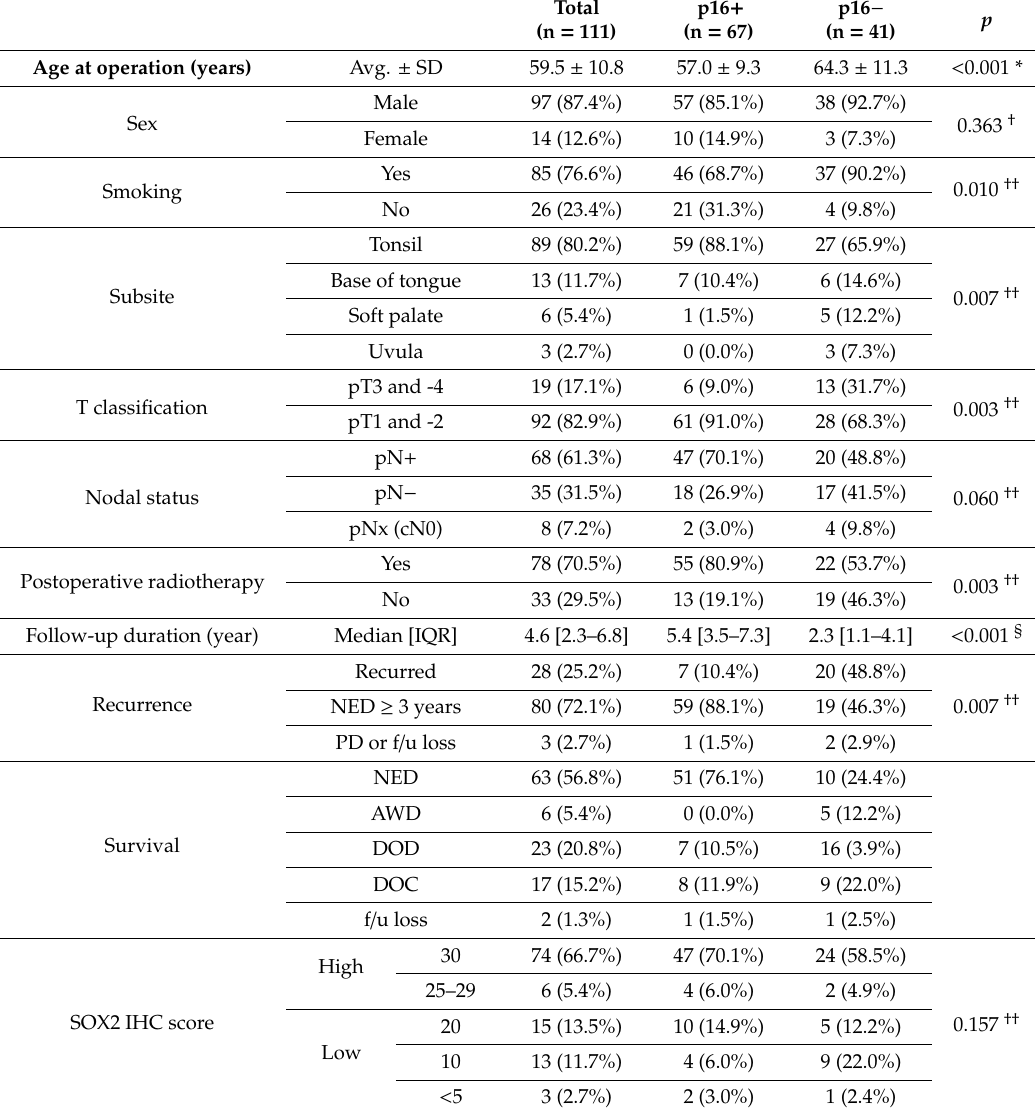
Table 1. Demographics for 111 oropharyngeal cancer patients. Three patients without p16 immunohistochemistry (IHC) scores were excluded from the subgroup